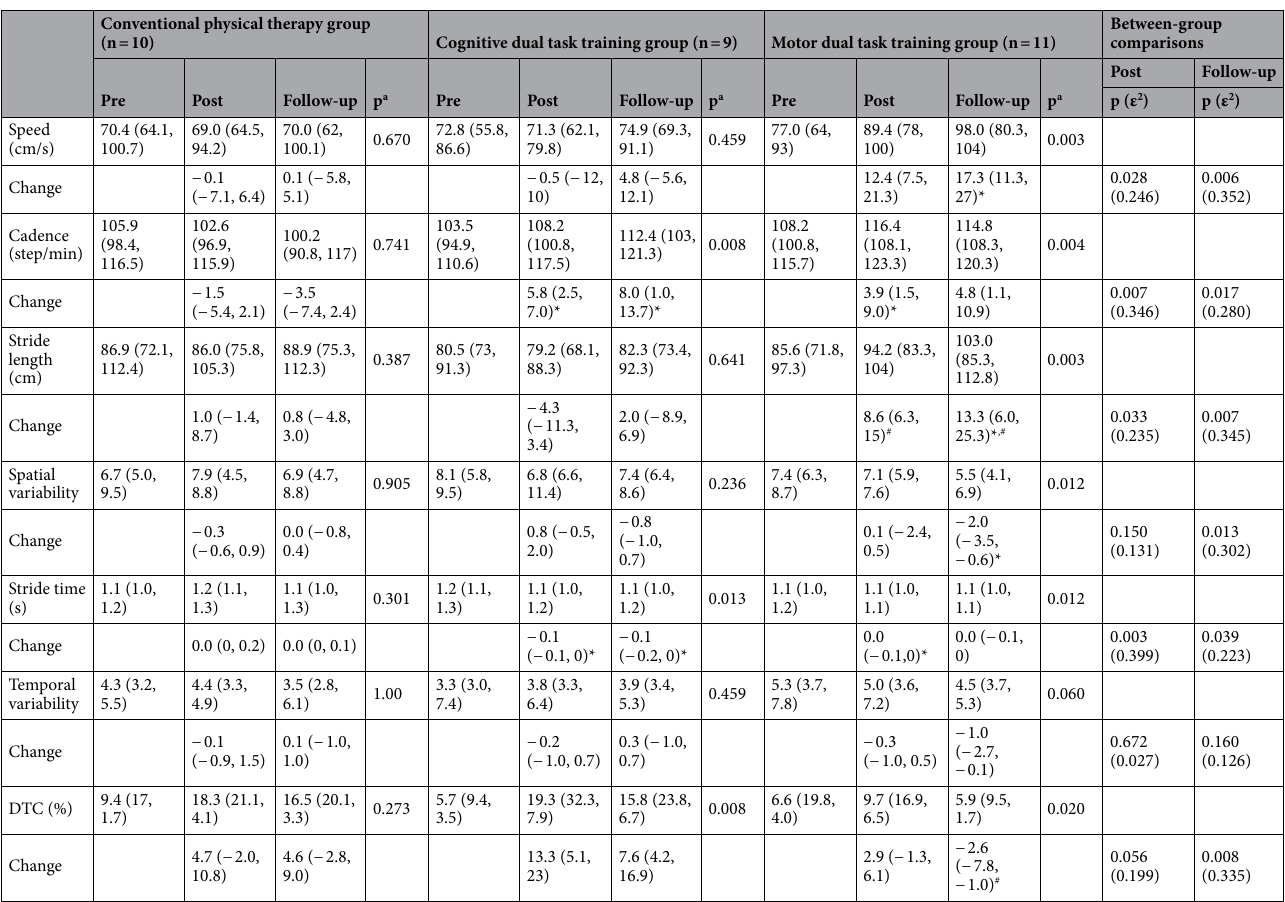
Table 3. Comparisons of motor dual task walking performance after training at different time point. Values are median (interquartile). Change values were calculated by subtracting the baseline data from the post- training data (Post) or by subtracting the baseline data from the follow-up data (Follow-up). a p value for within-group comparison using Friedman test. *p < 0.05 as compared with conventional physical therapy group. # p < 0.05 as compared with cognitive dual task training